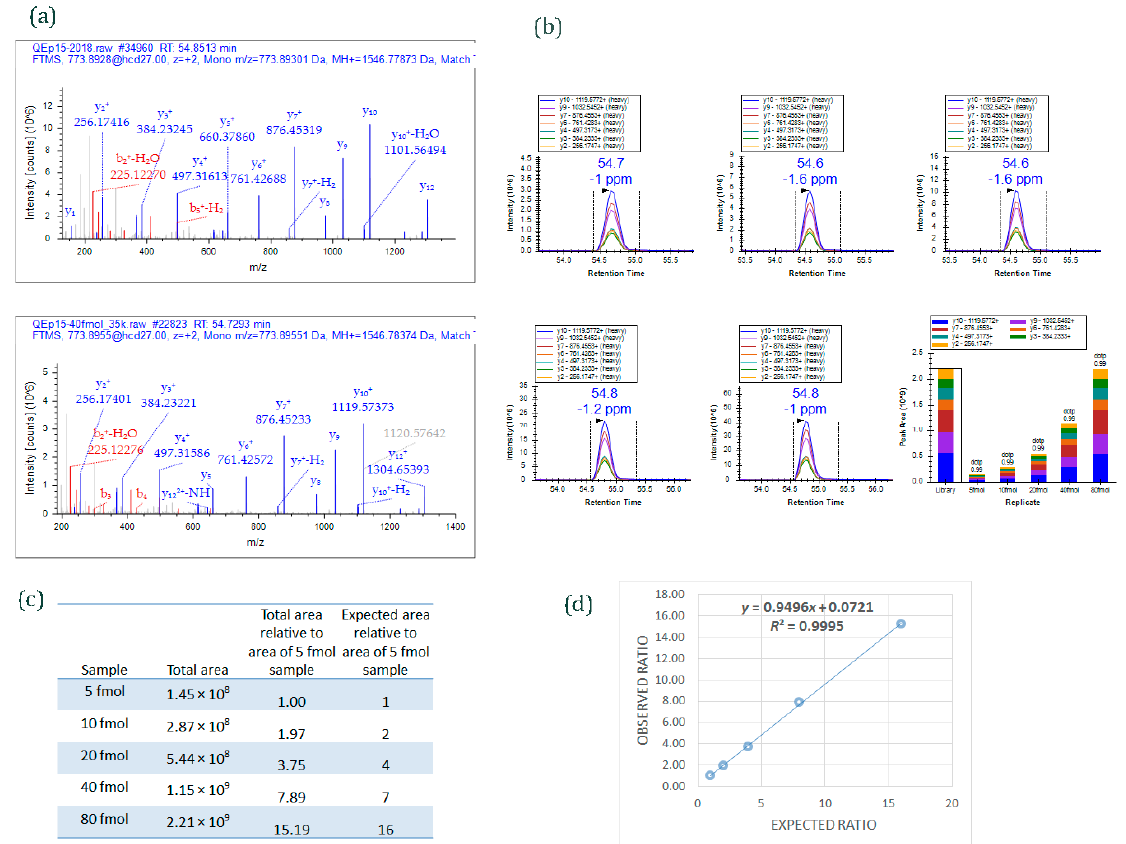
Figure 4. An example of data acquired by PRM method. Different amounts of a 15-peptide PRTC mixture (5, 10, 20, 40, and 80 fmol) was spiked into 100 ng HeLa digest and analyzed by PRM. ( a ) MS/MS spectrum of the heavy isotope labeled-peptide ELGQSGVDTYLQTK* ( m / z 773.8955, 2+) acquired using data-dependent acquisition ( upper panel) and used as an spectral library to match MS/MS spectrum of the peptide acquired by PRM method ( lower panel); ( b ) Graphs displaying chromatograms of fragment ions extracted from the peptide ELGQSGVDTYLQTK ( m / z 773.8955, 2+) at five different concentrations. Mass measurement error and retention time of the most intense transition is annotated above the peak. The vertical lines on either side of the peak indicate the integration boundaries for the peak. Bottom right plot: the total integrated fragment ion signal for the peptide at different concentrations is plotted as a bar graph; contribution from each individual fragment ion is displayed as a different color in the bars. Dot product (dotp) value indicates the degree of the match between spectral library MS/MS (Figure 4a) and the extracted ion chromatograms of the corresponding transitions [47]; high dotp indicates the absence of interfering signals [5]; ( c ) Total integrated area of the peaks of peptide ELGQSGVDTYLQTK at five different concentrations; ( d ) Scatter plot between expected ratios and observed ratios shows excellent correlation ( R 2 = 0.99). Skyline was used to analyze the PRM data.